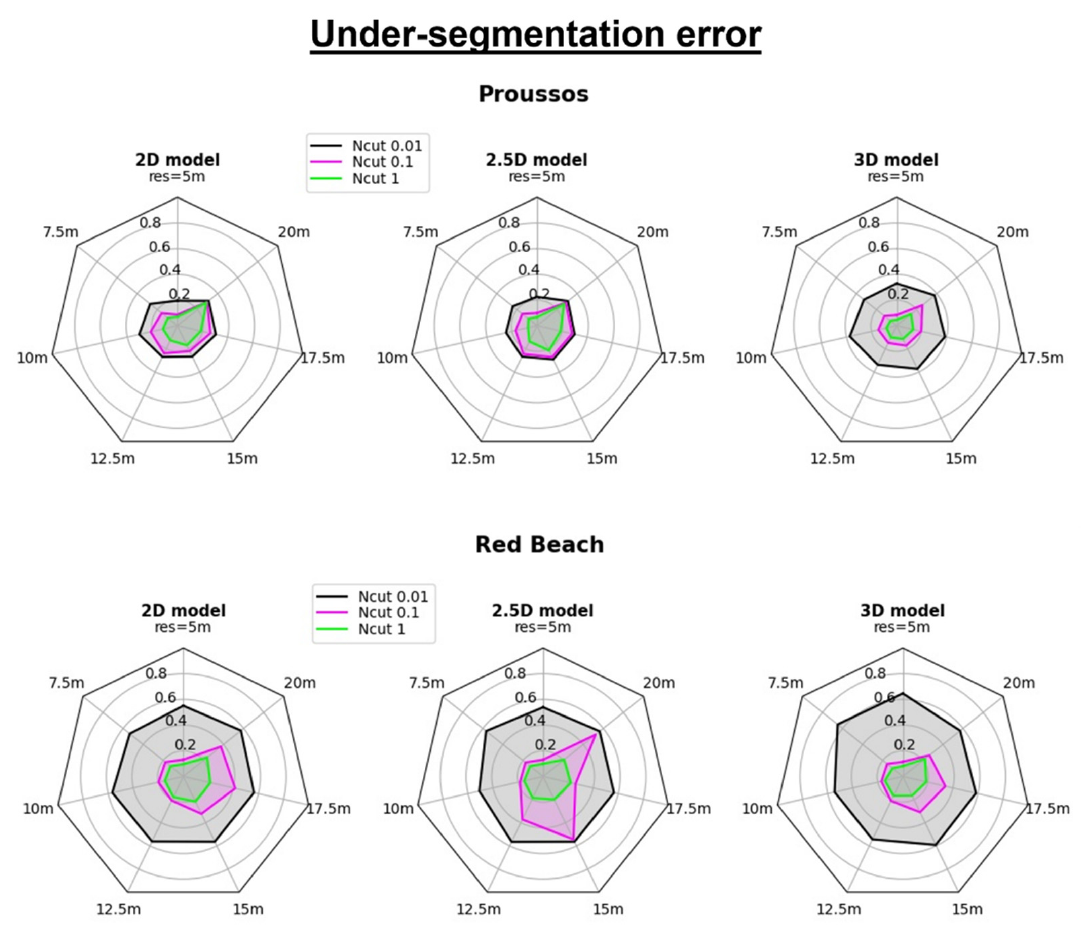
Figure 11. The under-segmentation error of the superpixel/supervoxel-based graph-based segmentation for each dimensionality of the UAV-derived input digital models.